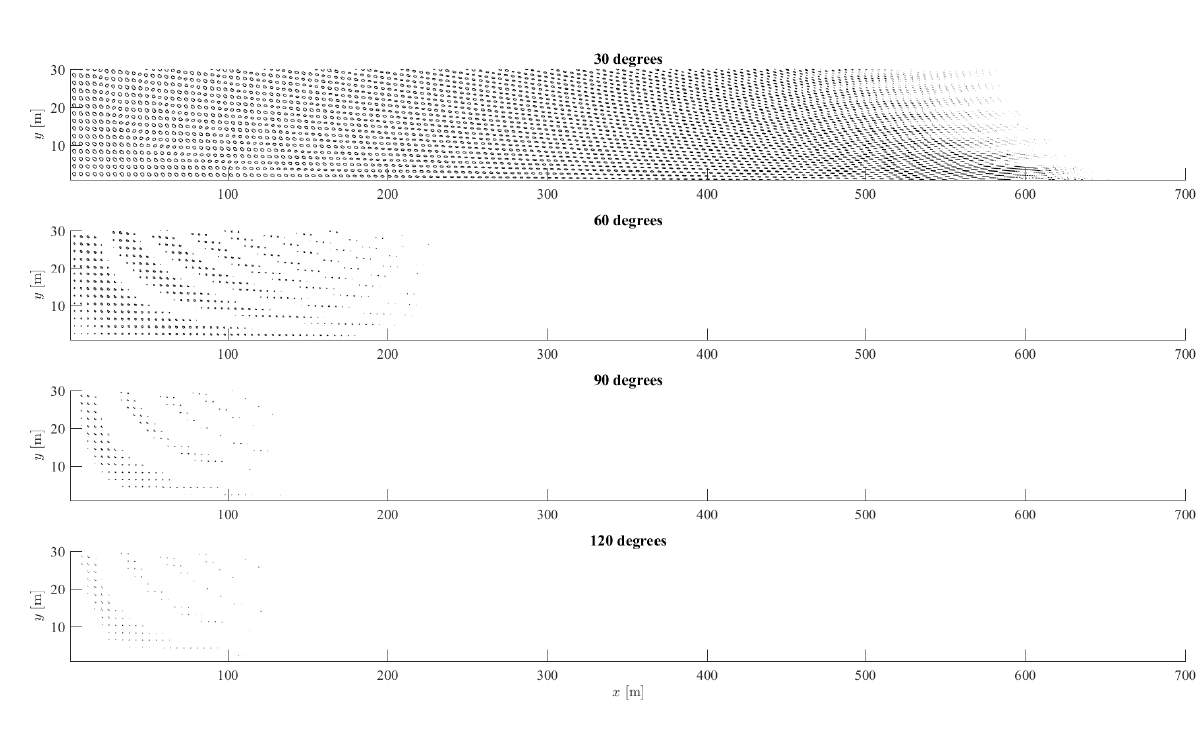
Figure 13: The same as Figure 11, but for semi-rigid walls, R h = R v = 0.5 .